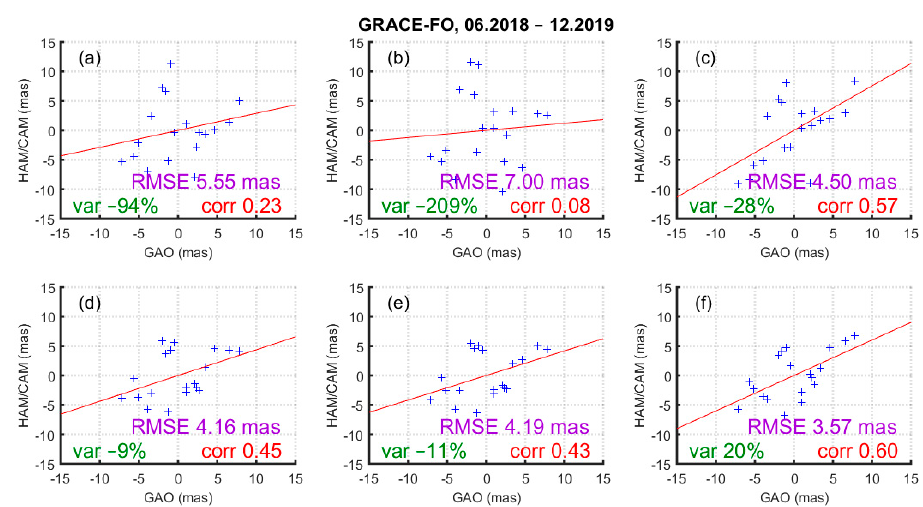
Figure 12. Scatter plots showing the relationship between the χ 1 component of GAO and HAM/CAM from ( a ) CSR GSM, ( b ) JPL GSM, ( c ) GFZ GSM, ( d ) CSR TWS, ( e ) JPL TWS, and ( f ) GFZ TWS. The red line was fitted to the data points using the least squares method. The values in purple indicate the RMSE, the values in red (corr) indicate the correlation coefficients between series, and the values in green (var) indicate the relative explained variances. The considered time period is June 2018 to December 2019. Note that the critical value of correlation coefficient for 12 independent points and a 95% confidence level is 0.50, while the standard error of the difference between two correlation coefficients is 0.47. All the parameters were computed after removal of trends.